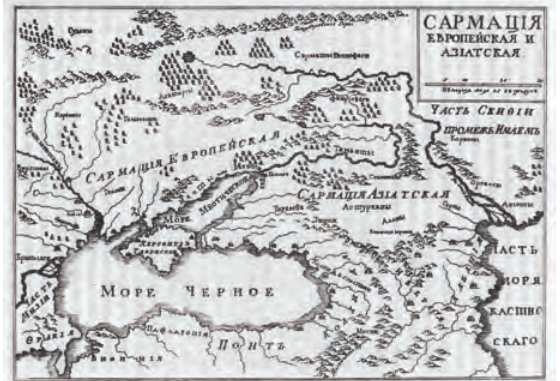
Fig. 10. Map of European and Asiatic